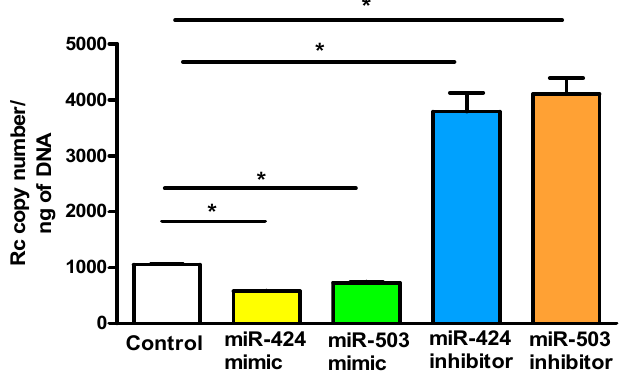
Figure 6. miRNA-mediated rickettsial internalization into host endothelial cells: ECs were transfected with a miR-424 mimic (1 nM) or inhibitor (200 nM) prior to infection with R. conorii for 6 h. Cells were lysed and DNA was isolated using a Qiagen kit for determination of the copy number of rickettsiae by qPCR. The data are presented as the mean ± SE of three separate experiments. The asterisk (* p ≤ 0.01) indicates statistically significant change.